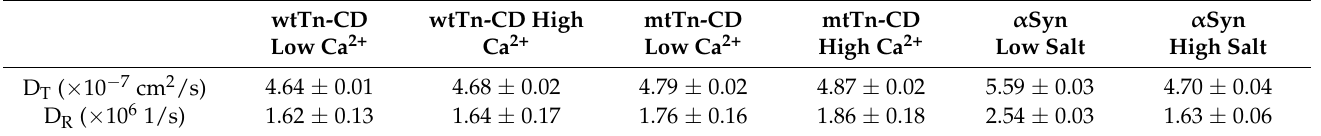
Figure 1. Summary of the structural models. ( a , c ) Gallery of examples of the structural models of the wtTn-CD and the mtTn-CD, respectively. A total of 10 models, arbitrarily selected from the ensembles of 1000 models, are superimposed so that the central regions observed by the crystal structure coincide. ( e ) Gallery of examples of the structural models of α Syn. A total of 5 examples of the dummy-atom models, arbitrarily chosen from the ensembles of 100 models, are shown. ( b , d , f ) the ρ ( r ) curves of the wtTn-CD, the mtTn-CD, and α Syn, respectively. Panels ( a , c ) are drawn using UCSF Chimera [36], and ( e ) are drawn using PyMOL. Table 1. Summary of the diffusion coefficients calculated from the structural